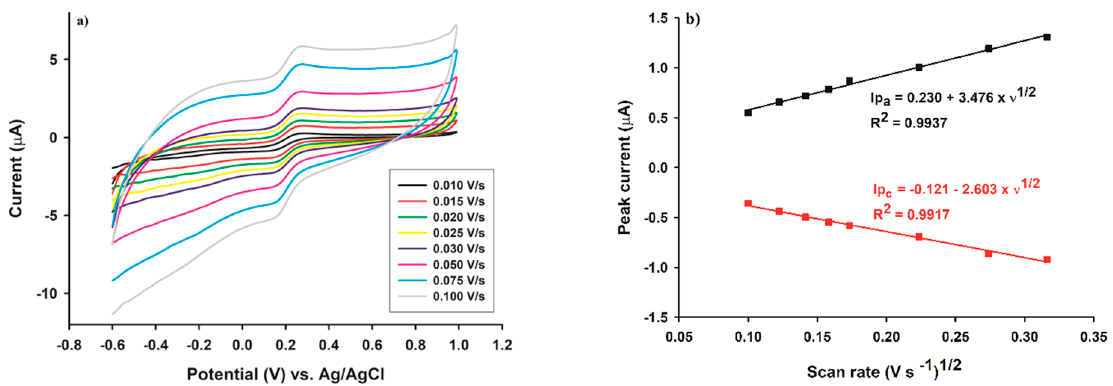
Figure 3. ( a ) Cyclic voltammograms in a solution of 5.0 × 10 − 3 mol L − 1 K 3 [Fe(CN) 6 ] (0.1 mol L − 1 KCl) at different scan rates from 0.010 to 0.100 V s − 1 using the TPP/rGO@Pd0 sensor (working conditions: potential range from − 0.6 to 1.0 V and step potential 0.025 V). ( b ) Dependence of the peak current on the square root of the scan rate using the TPP/rGO@Pd0 sensor .